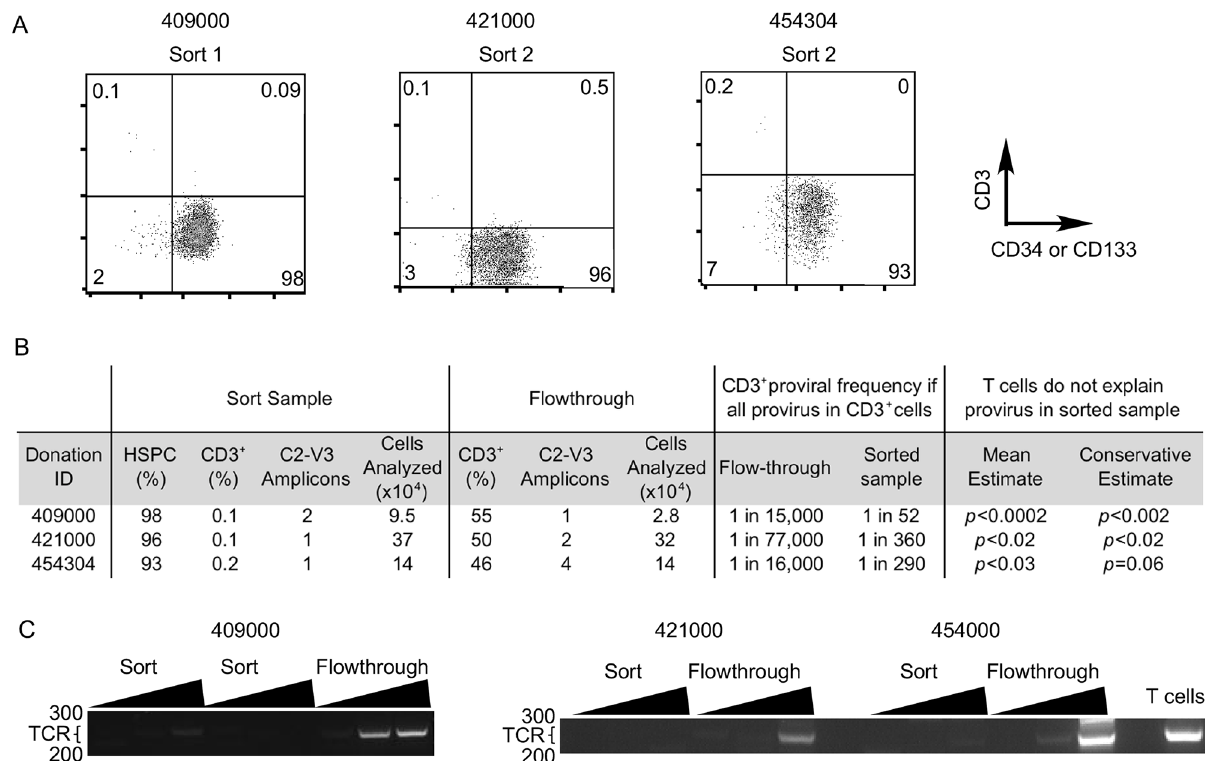
Fig 2. Near-full-length HIV provirus in HSPCs preparations is unlikely to be from T cell contamination. A. Flow cytometric analysisof HSPCs from three donors that harborednear full-lengthgenomes.Numbersindicate the frequency of events falling into each quadrant. CD133 or CD34 were assessedfor Sort 1 or Sort 2 respectively.B. Summary table showingdata for Fisher’s exact test, which compares calculatedfrequenciesof provirus assumingall provirusoriginatesfrom T cells. PCRs were performed at limiting dilution.Significantly discrepantfrequencies in sorted and flow-throughsamplesindicate T cells are an unlikelysource of provirus in sorted samples. Conservativeestimate compares the top of the 95% confidenceinterval for the calculatedinfectionrate for flow-through CD3 + T cells with the bottom of the 95% confidenceintervalfor the calculatedinfection rate for CD3 + T cells in the sorted HSPCs. C. Agarose gel analysisof rearrangedT cell receptor gene PCR. 50, 100 or 200 cell equivalents of DNA from the first round PCR reactionthat yieldedeach provirus were added to each reaction. For “T cells”, 200 cell equivalents of DNA from purifiedCD4 + T cells were added to the reaction. The expected size of the ampliconsis 250–300bp. Numbers to the left of each gel indicatethe location of molecularweight